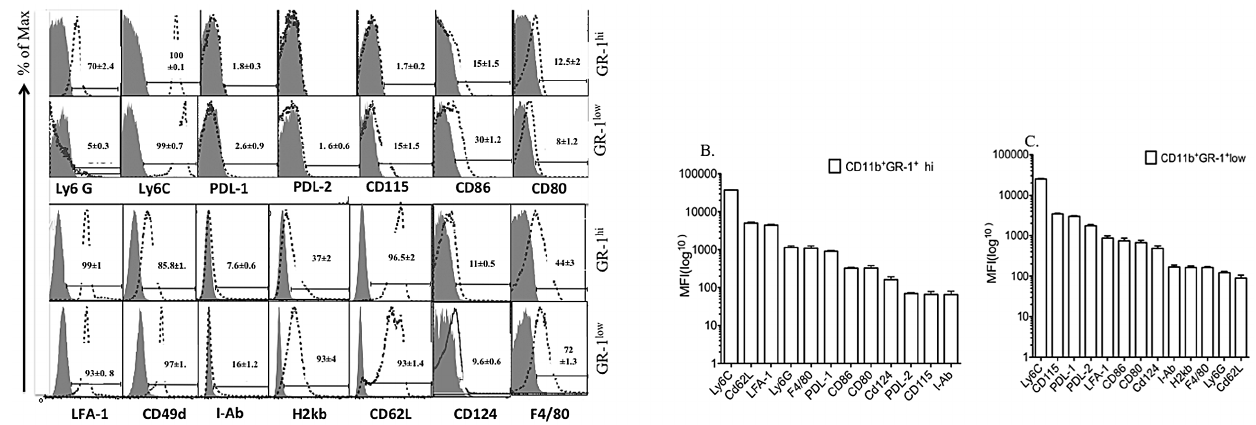
Figure 2. Expression of surface molecules on BM-derived CD11b + GR-1 + IMC subsets. Flow cytometry analysis of cell surface marker expression on lineage ( 2 ) CD11b + GR-1 hi and CD11b + GR-1 low/int IMC subsets was performed as described in the Methods section. Histograms represent expression of the indicated markers on viable CD11b + GR-1 + cells (open dashed histograms) compared with gated isotype control (filed gray histograms). Data represent of average of frequencies ( 6 SD) from replicate samples. B) Logarithmic mean fluorescence index (MFI) of three experiments for both subsets of CD11b + GR-1 hi and CD11b + GR 2 /low/int IMCs respectively (B & C) ordered by marker from the greatest to the least mean MFI.